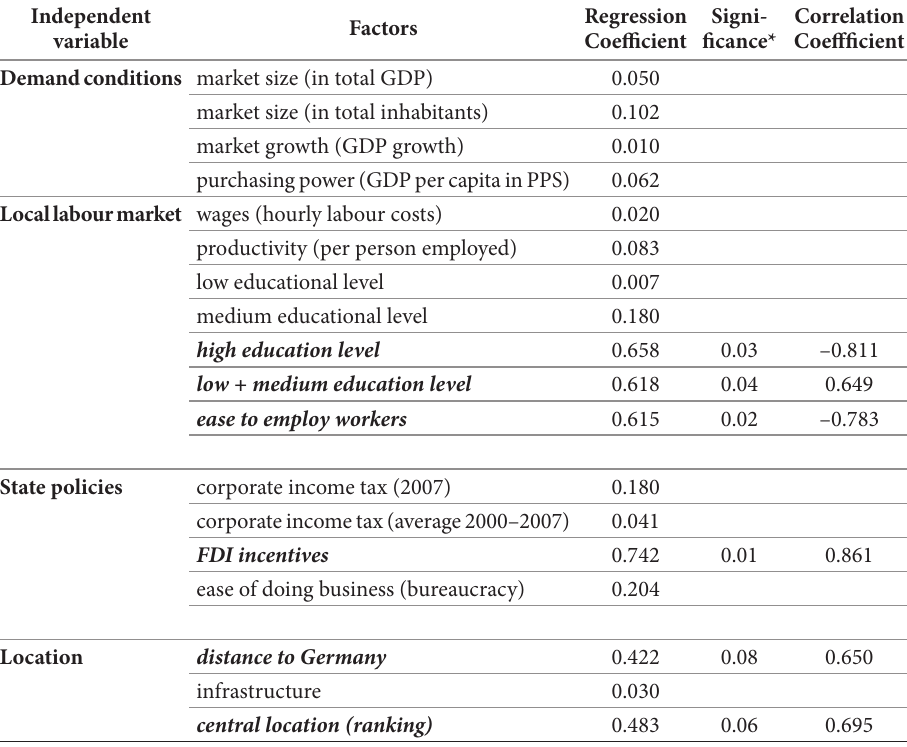
Table 2. Determinants of production transfer of German MNEs Independent